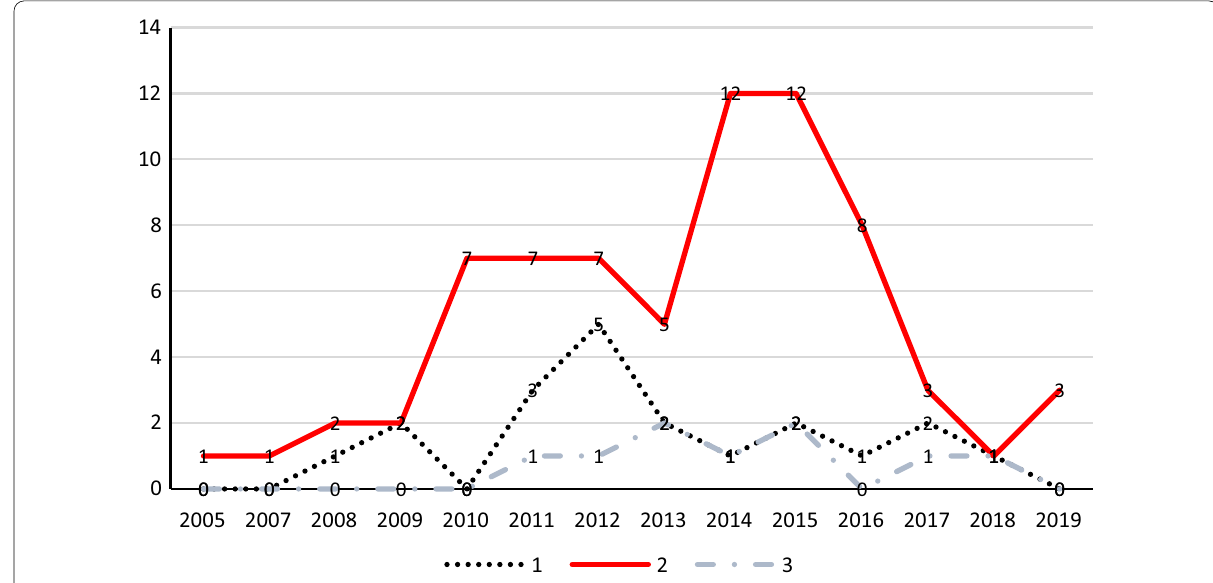
Fig. 6 Publication distribution in terms of research methods over the years. (Note: 1